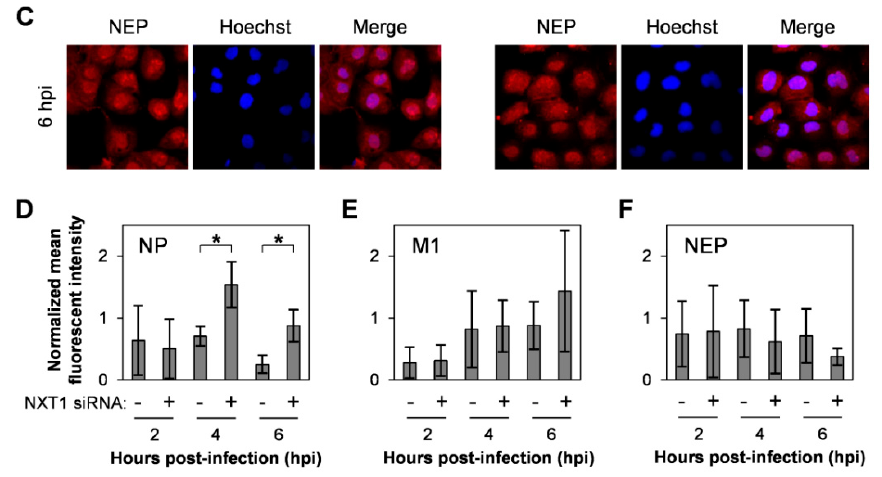
Figure 3. NXT1 knockdown accumulates viral NP and M1 proteins in the nucleus. ( A – C ) MDCK cells were transfected with control or NXT1 siRNA for 48 h and infected with influenza A/WSN/33 virus at MOI = 2. After 2, 4, or 6 hpi, the cells were analyzed by immunofluorescent staining with anti ‐ NP ( A ); anti ‐ M1 ( B ); or anti ‐ NEP ( C ) antibody, followed by Alexa Fluor 594 goat anti ‐ mouse or Alexa Fluor 594 goat anti ‐ rabbit antibody. Nuclei were counterstained with Hoechst 33342 and the cells were visualized under an Olympus laser scanning confocal fluorescence microscope. White arrows indicate nuclear accumulation of NP or M1 proteins; ( D – F ) Mean fluorescence intensity of NP, M1, and NEP in the nucleus derived from ( A – C ) (normalized by the mean fluorescence intensity of Hoechst 33342, n ≥ 50). Data represent the mean ± SD values from three independent experiments. * indicates a significant difference at p < 0.05 (unpaired t ‐ test).